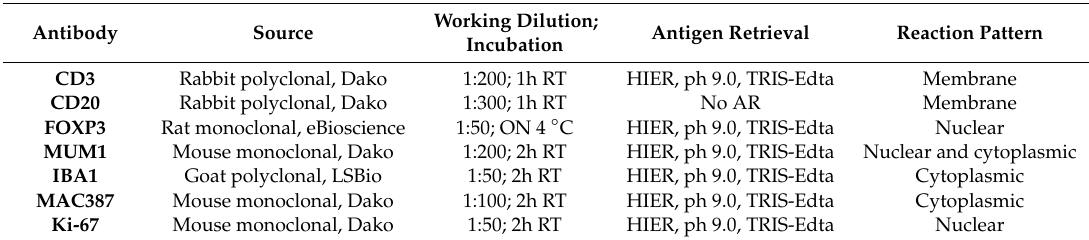
Table 1. Antibodies and protocols used for the characterization of the immune infiltrate in equine penile squamous cell carcinomas